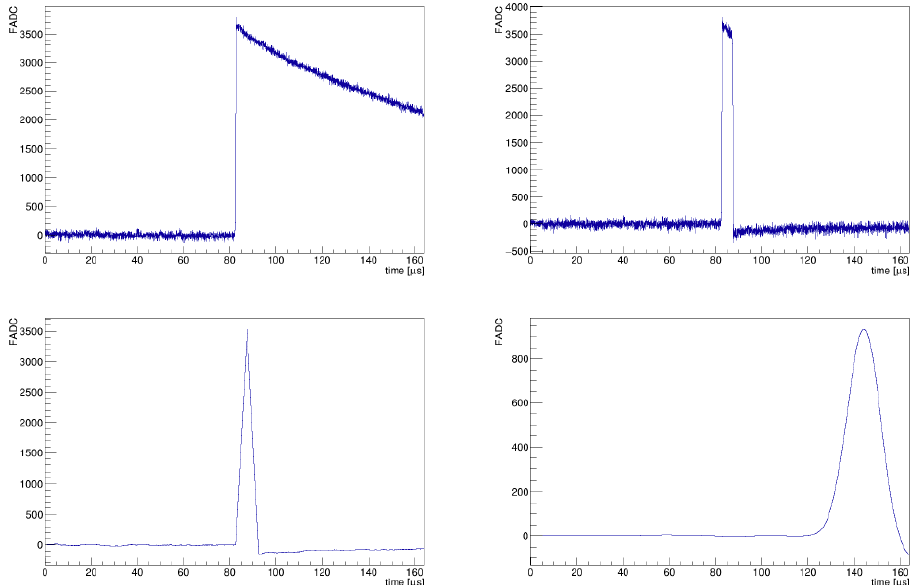
Figure 9. The G ERDA Phase I waveform filtering procedure. Top left: a charge waveform after inversion and baseline subtraction. Top right: the differentiated waveform. Bottom: the differentiated waveform after one ( left ) and 25 ( right ) MA operations.